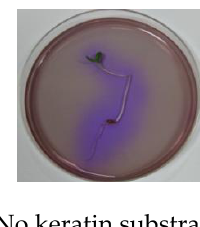
Figure 6. Proton pump test applied to tomato seedlings treated with PHs from Trichoderma isolates compared. ( a ) Tomato seedling treated with tap water (control). ( b ) Treatment with PHs from T. atroviride grown on different media. ( c ) Treatment with PHs from T. asperellum grown on different media. Pictures show root acidification activity of 10 days old seedlings treated with fungal PHs for 60 min. The yellow color indicates acidic pH, purple color denotes neutral to alkaline pH.